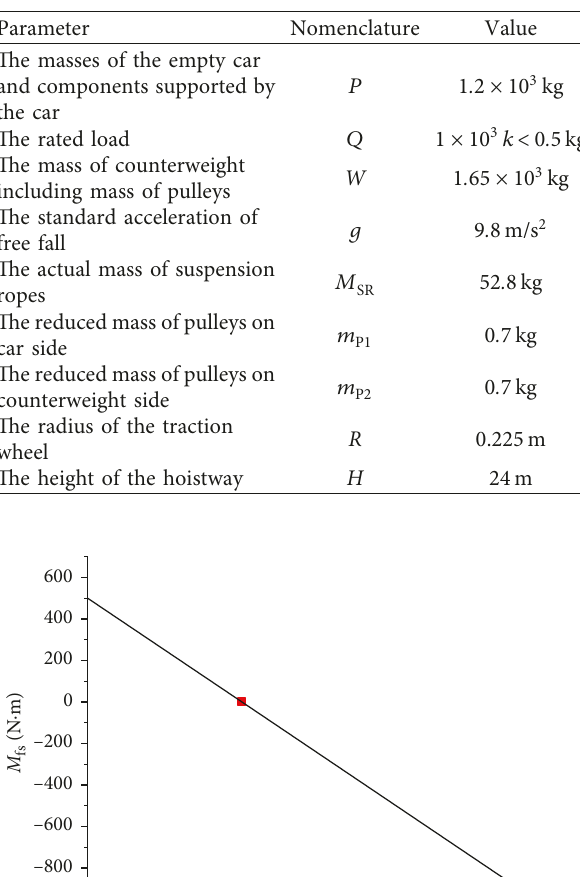
Table 1: Model parameter values.